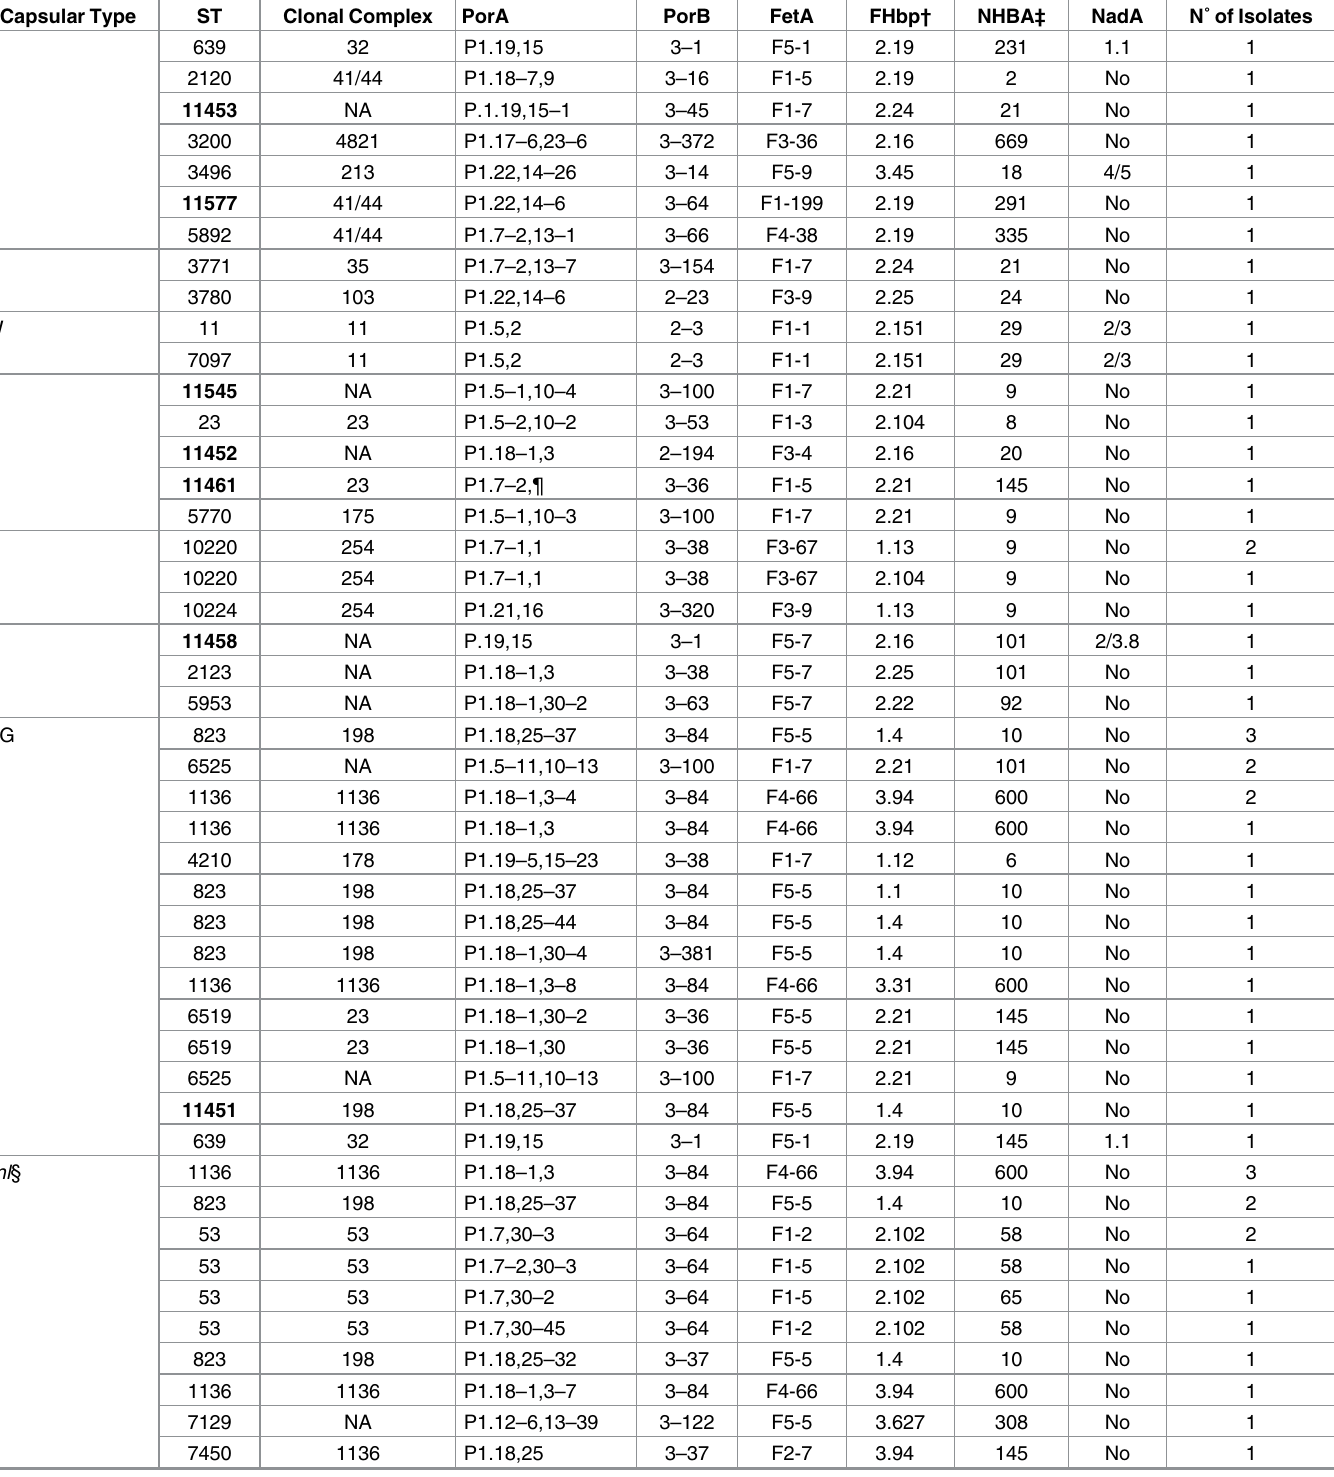
Table 1. Genotypic characterization of the 59 N . men ingitidis isolates. Capsular